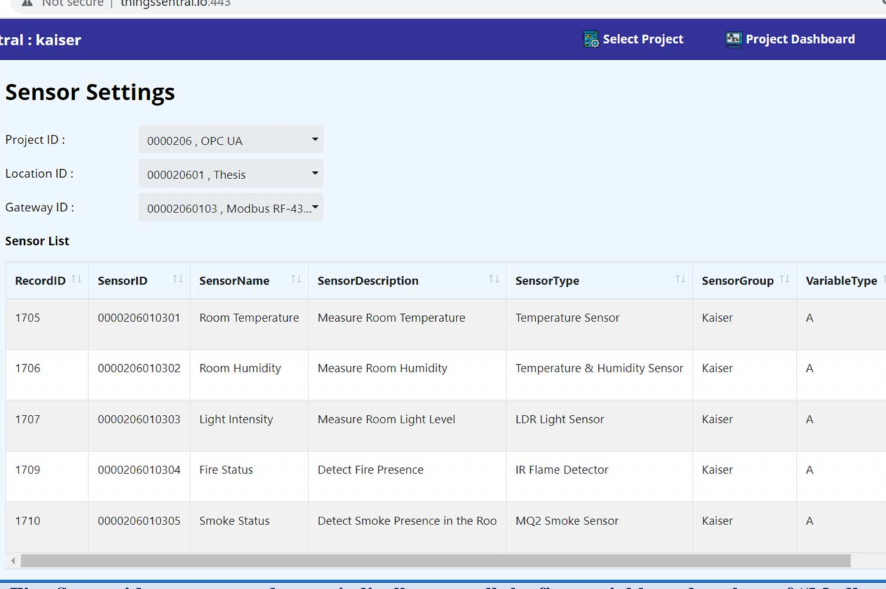
Figure 10. ThingsSentral TM cloud platform Sensor Settings page.